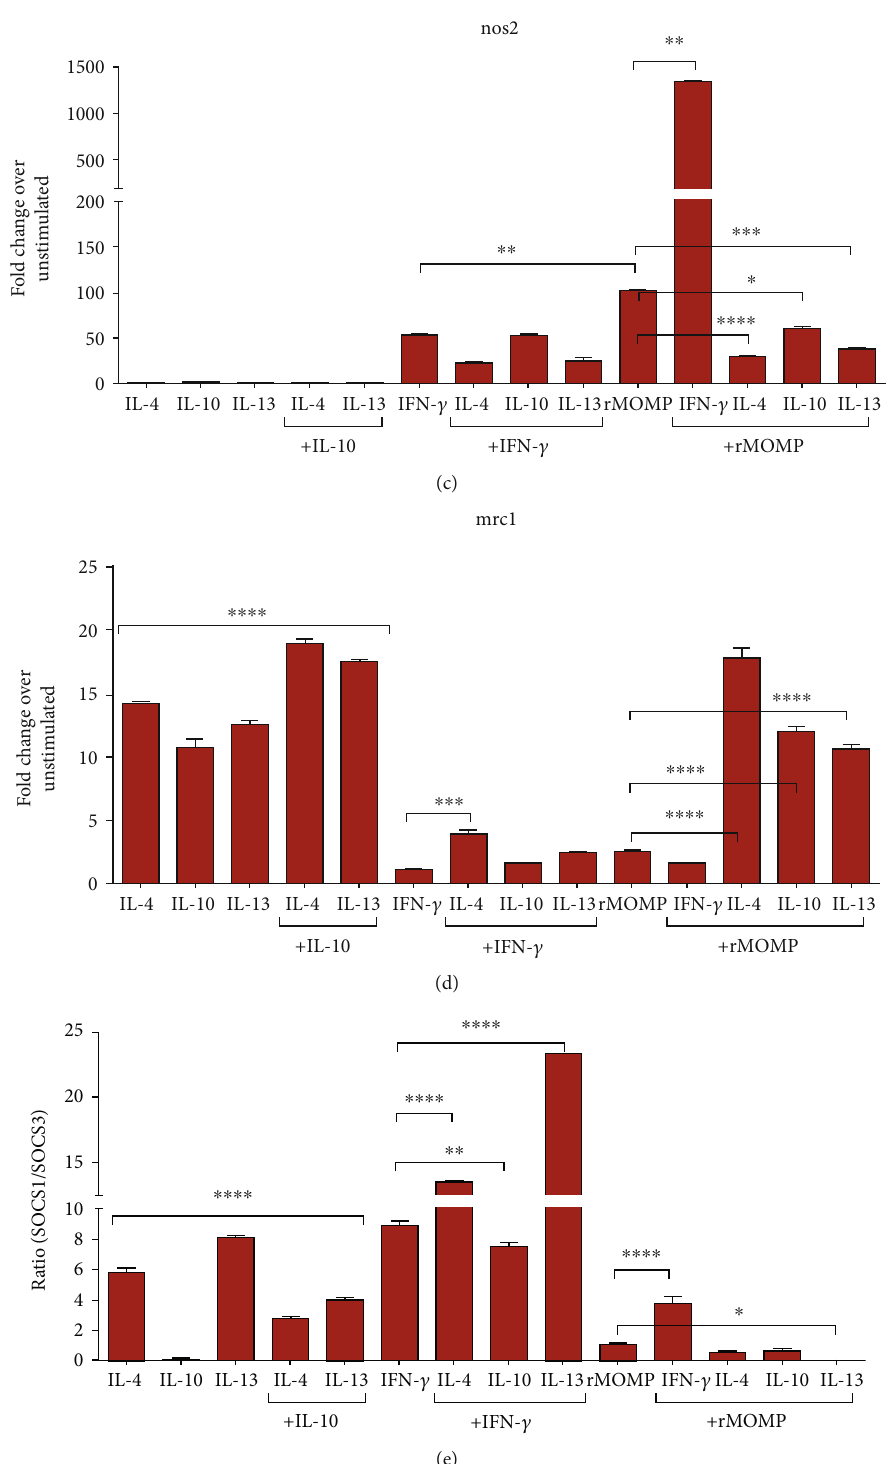
Figure 7: Impact of macrophage polarization on TNF expression, macrophage phenotypes as well as SOCS ratios in rMOMP cultures. Macrophages (10 6 /mL) were pre-incubated with IL-4 or IFN- γ (each at 10ng/mL) for 1h followed by stimulation with either Cm or its rMOMP in the presence and absence of IL-10 for an additional 24h. Cell-free culture supernatants were collected to quantify TNF by ELISA (A-B). Macrophages were pre-incubated with IL-4, IL-10, IL-13, or IFN- γ for 1 h followed by stimulation with rMOMP for an additional 24h. The mRNA gene transcripts for nos2, mrc1, socs1 and socs3 (C-E) were quanti fi ed via TaqMan qRT-PCR. An asterisk indicates signi fi cant di ff erences ( P < 0.05), and P values were calculated as described in Figure 1 legend. Each bar represents the mean ± SD of samples run in triplicates, and each experiment was repeated at least 3 to 4 times with a representative experiment